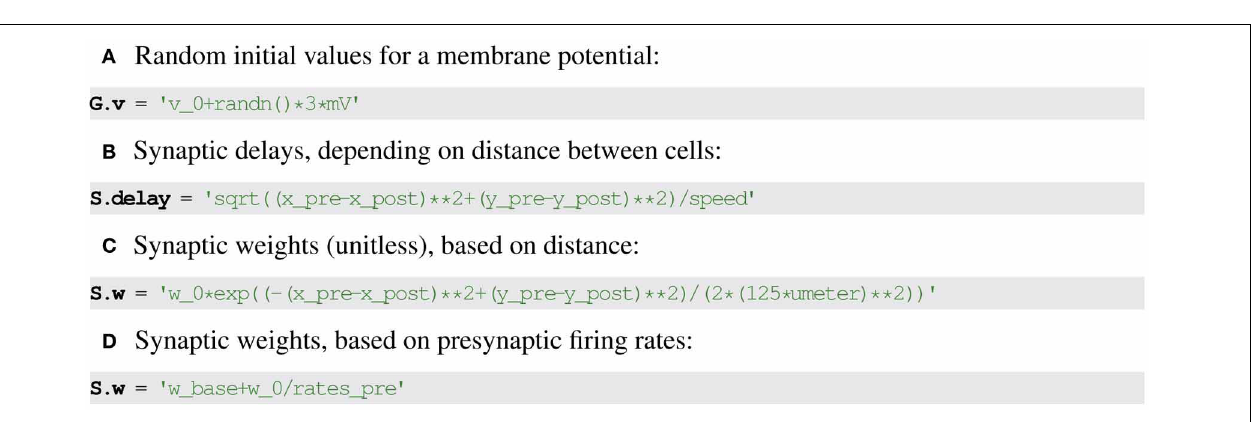
suffix _pre and _post . Optionally, a value or expression for the probability of creating a synapse can be given as the keyword argument p . The number of synapsestocreateforeachconnectioncanbegivenasthekeywordargument n .